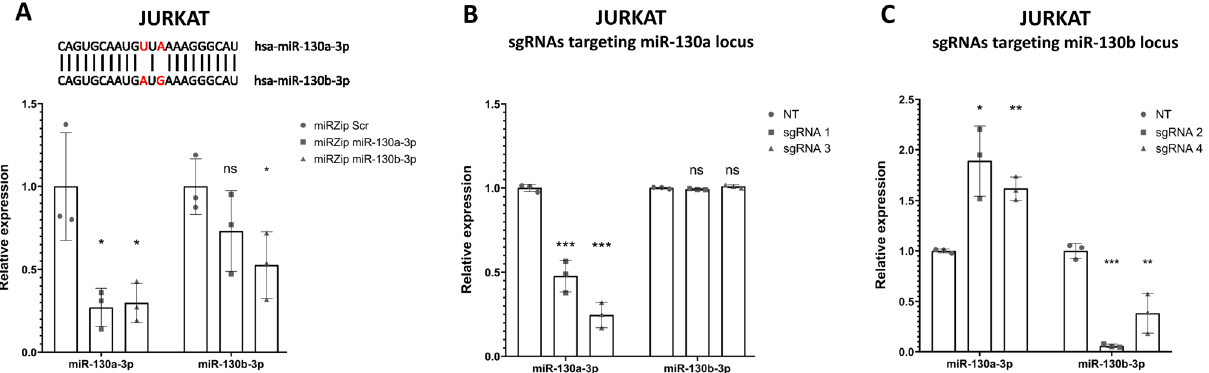
Figure 5. Comparison of specificity of miRZip and dCas9-KRAB approaches towards selective silencing of miR-130a-3p and miR-130b-3p. ( A ) Normalized expression of miR-130a-3p and miR-130b-3p upon the use of miRZip vector encoding shRNAs targeting miR-130a-3p or miR-130b-3p as compared do scrambled control miRZip vector (Scr) in JURKAT cell line. ( B ) Normalized expression of miR-130a-3p and miR-130b-3p upon the use of dCas9-KRAB system and sgRNAs targeting mir-130a TSS as compared do scrambled control (Scr) in JURKAT cell line. ( C ) Normalized expression of miR-130a-3p and miR-130b-3p upon the use of dCas9-KRAB system and sgRNAs targeting mir-130a TSS as compared do scrambled control (Scr) in JURKAT cell line. * p < 0.05; ** p < 0.01; *** p <